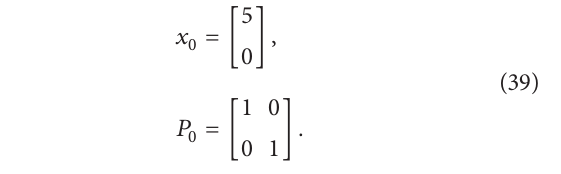
Algorithm 6 (fault detection using a variant Kalman filter).